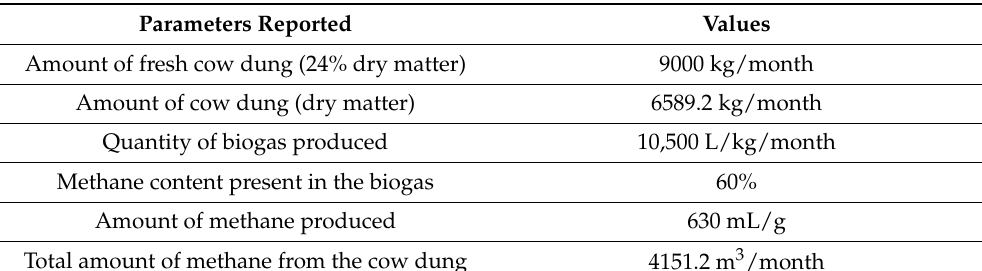
Table 1. Calculation of estimated biogas production (per